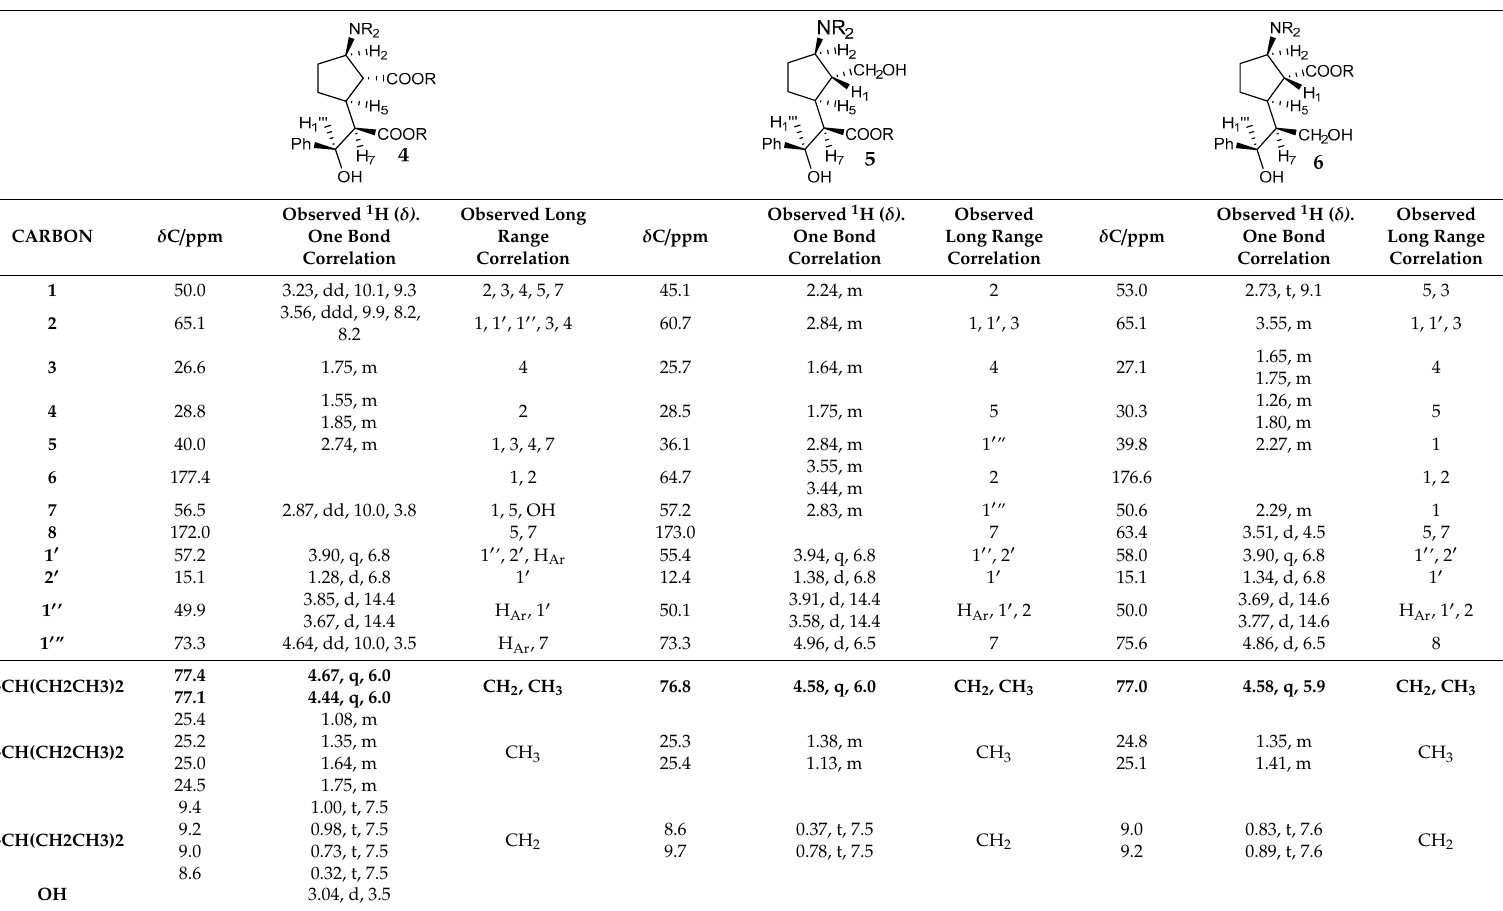
Table 1. One bond and long-range 2D 1 H- 13 C correlation for compounds 4 , 5 and 6 . Table 1. One bond and long-range 2D 1H-13C correlation for compounds 4 , 5 and 6 . Table 1. One bond and long-range 2D 1H-13C correlation for compounds 4 , 5 and 6 . Table 1. One bond and long-range 2D 1H-13C correlation for compounds 4 , 5 and 6